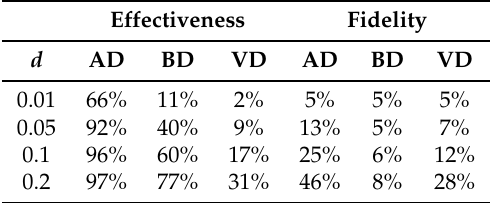
Table 2. Averages of effectiveness and fidelity values calculated for each simulated sampling rate, after